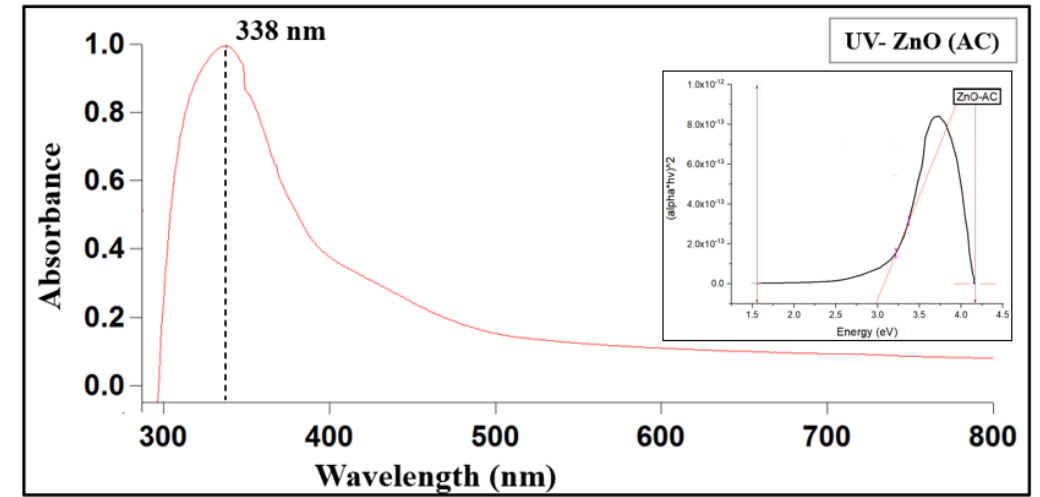
Figure 4. UV-Vis spectrum of Zinc oxide nanoparticles with Tauc’s plot in the inset showing energy band gap intercept at 3 eV.